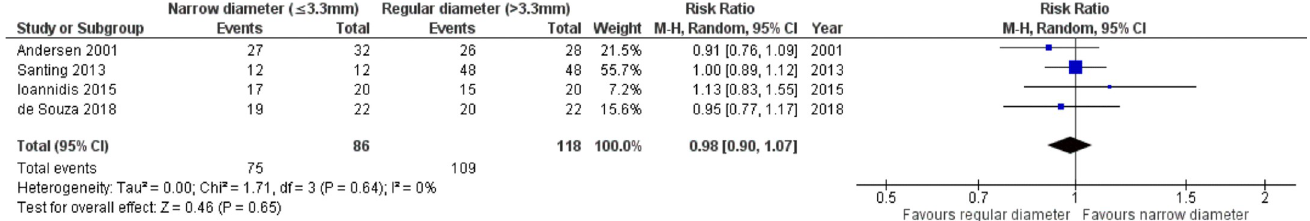
PLOS ONE | https://doi.org/10.1371/journal.pone.0225046 November11,